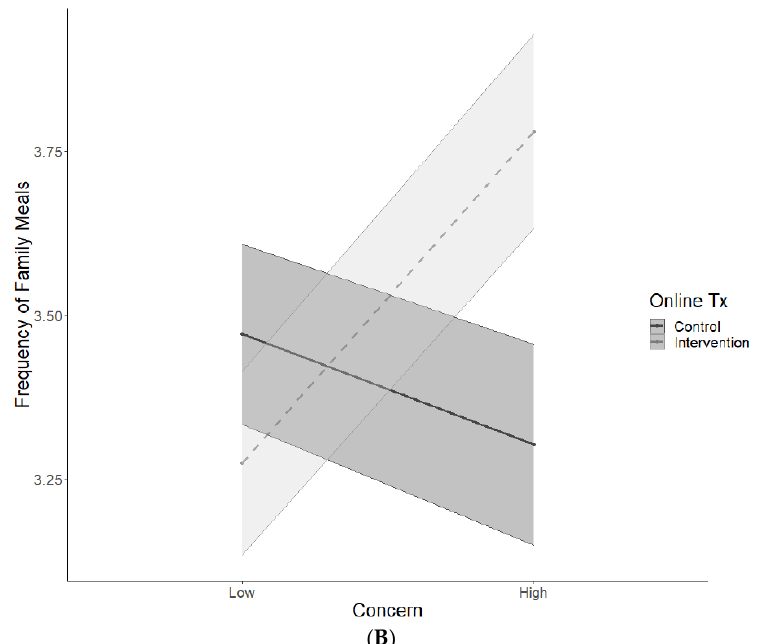
Figure 2. Two-way interactions with parenting feeding practices, including time x restriction ( A ) and online treatment x concern ( B ) predicting frequency of family